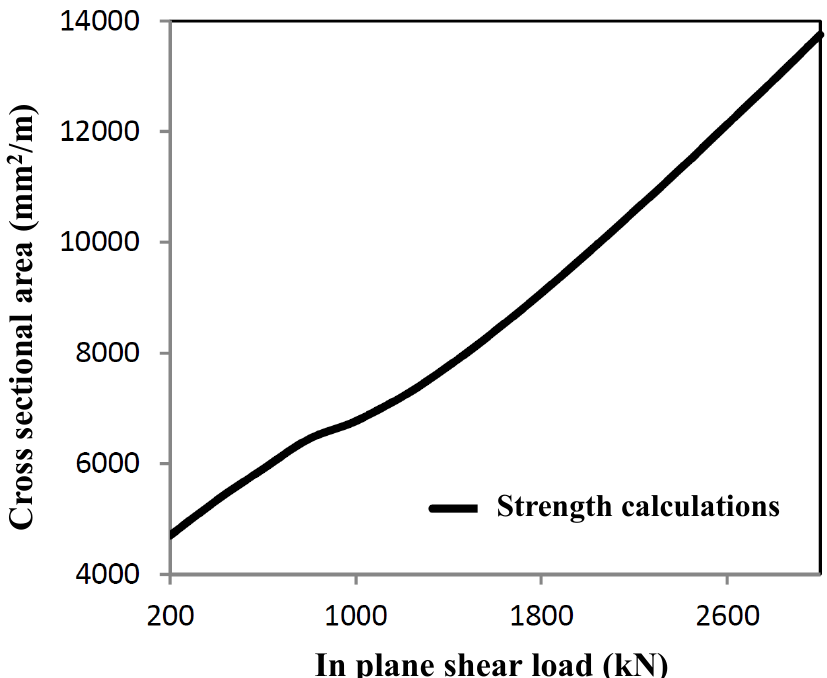
Figure 4. Minimum cross-section necessary for shear load combinations.